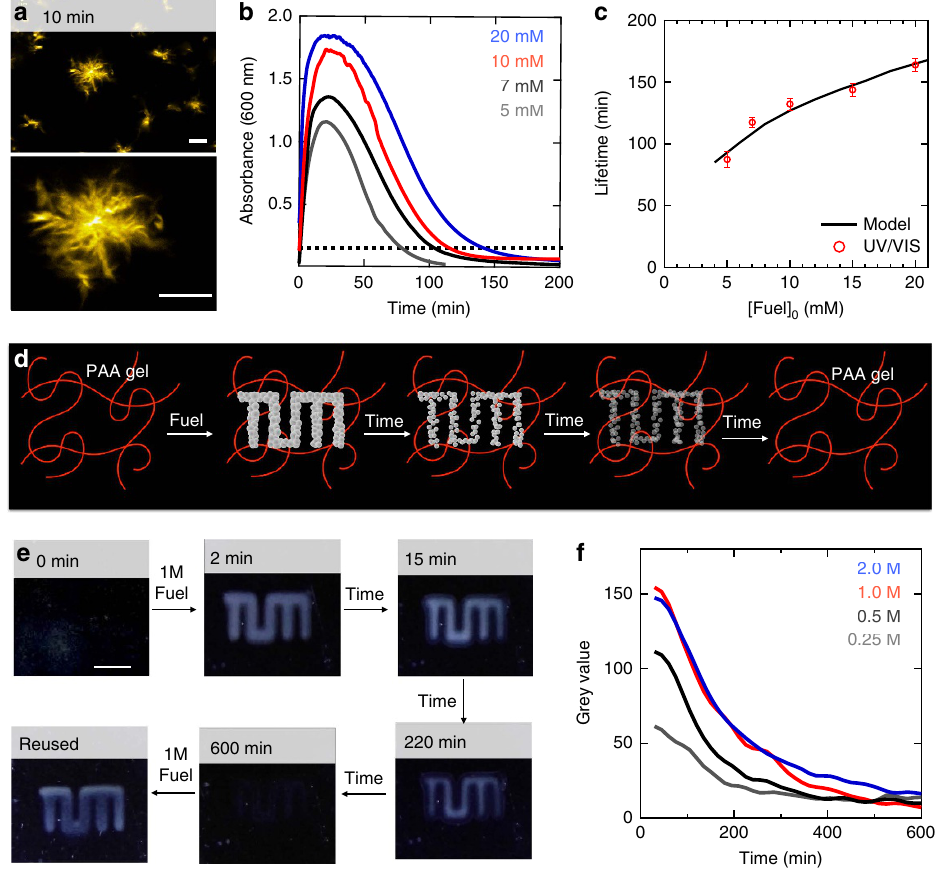
Figure 3 | Self-erasing inks with a tunable lifetime formed by Fmoc-D. ( a ) Confocal micrographs of a solution of 10mM Fmoc-D anhydride 10min after addition of 10mM EDC in the presence of 2.5 m M Nile Red (scale bars represent 10 m m). ( b ) Absorbance at 600nm as a measure for turbidity for solutions of 10mM Fmoc-D against time after addition of a batch of fuel. The dotted black line represents the selected threshold of 0.1 absorbance units. ( c ) The lifetime of the turbidity of the samples as determined by data from b (markers) and calculated by the kinetic model (solid lines) against initial fuel concentration. Error bars represent the s.d. ( n ¼ 3). ( d ) Schematic representation of self-erasing medium. Fmoc-D is dissolved in a 30% polyacrylamide hydrogel. Only where fuel is applied turbidity appears. ( e ) Photographs of gels over time. The polyacrylamide gels were placed on a black surface and side-lit with white light to improve contrast. After 600min, no evidence of the original image was found and the material was rinsed and reused (scale bar represents 1cm). ( f ) Average grey values of photographs of inked areas over